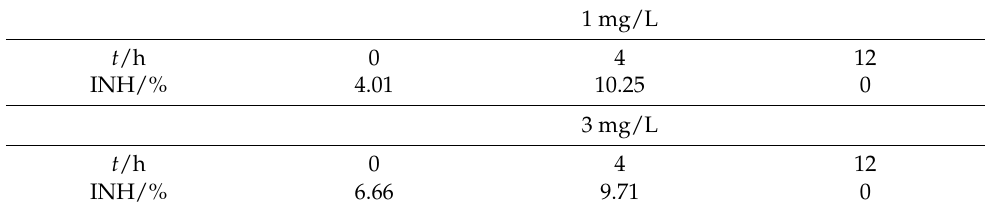
Table 3. Inhibition of samples before and after photolysis.